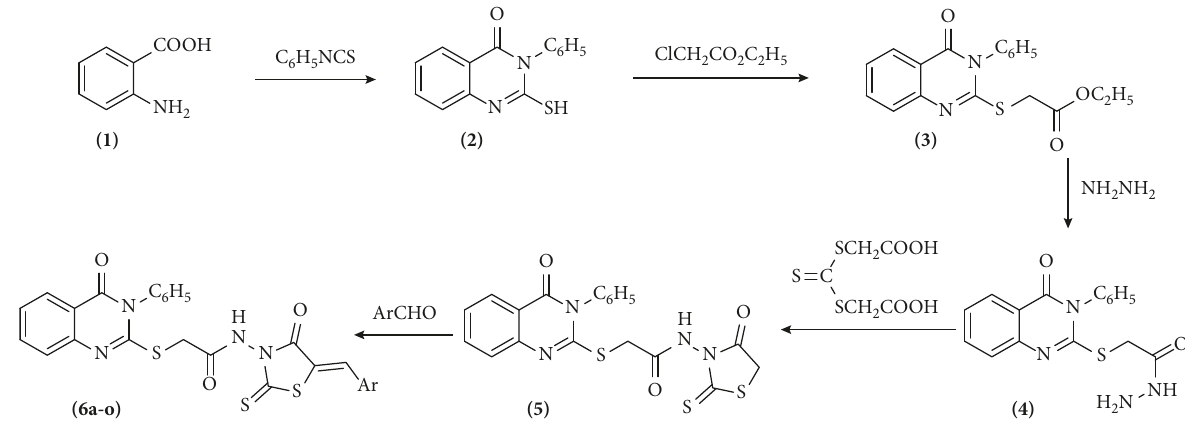
Scheme 1: Synthetic route for the preparation of the target compounds. Ar � 4-(CH 3 ) 2 NC 6 H 4 ( 6a ), 4-BrC 6 H 4 ( 6b ), 4-ClC 6 H 4 ( 6c ), 4-FC 6 H 4 ( 6d ), 2-FC 6 H 4 ( 6e ), 4-CH 3 OC 6 H 4 ( 6f ), 4-HOC 6 H 4 ( 6g ), 3-HOC 6 H 4 ( 6h ), C 6 H 5 ( 6i ), 4-O 2 NC 6 H 4 ( 6j ), 3-O 2 NC 6 H 4 ( 6k ), 2-O 2 NC 6 H 4 ( 6l ), 3, 4-(OCH 2 O)C 6 H 3 ( 6m ), 3-CH 3 O-4-HOC 6 H 3 ( 6n ), and C 6 H 5 CH � CH ( 6o